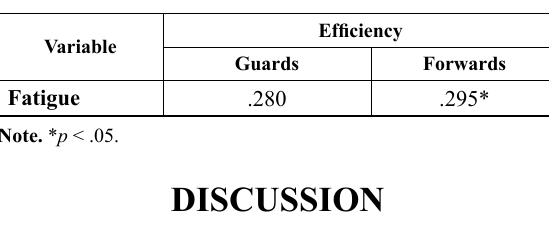
Table 4. Correlation coefficients of efficiency and fatigue